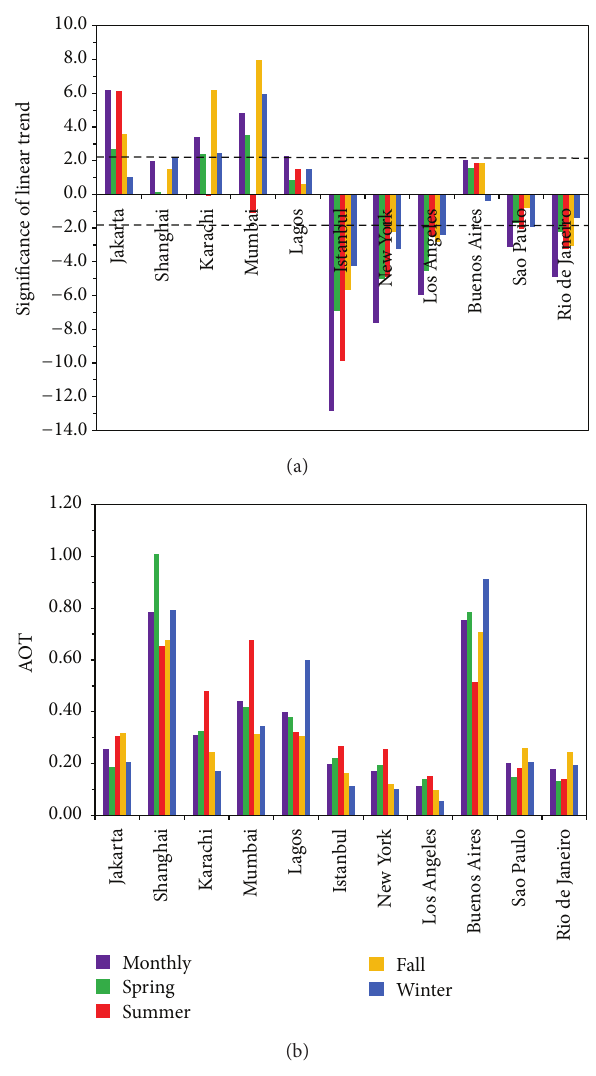
Figure 4: (a) The significance of linear trends of monthly and seasonal mean AOT and (b) temporal averaged seasonal mean AOT values for the eleven megacities where the positive or negative trend of monthly mean AOT is at a confidence level close to or above 95%. in Sao Paulo, while the corresponding seasons are summer and winter, respectively, in Rio de Janeiro. Negative